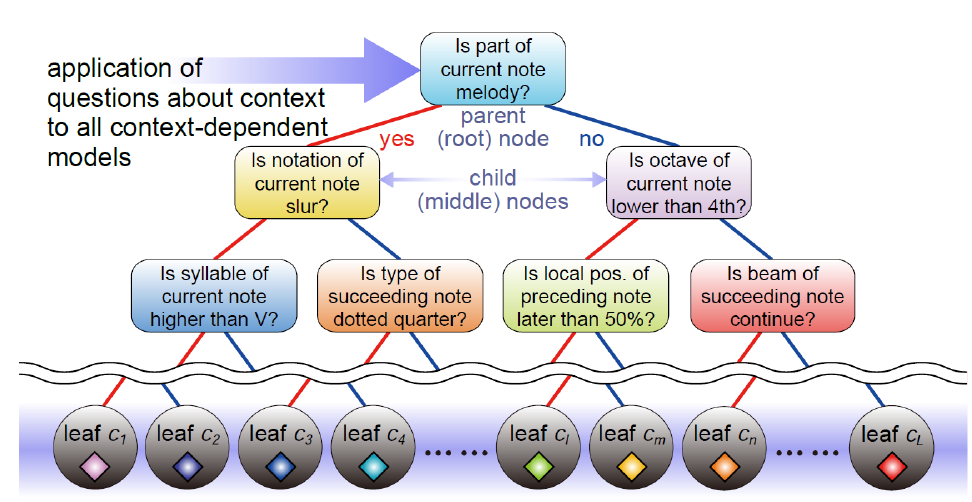
Figure 7. Binary tree-based clustering of the local context